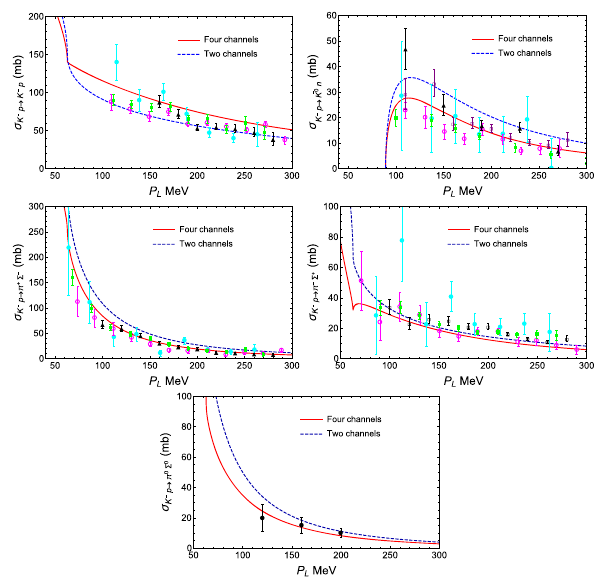
¯ K 0 n , π + (cid:4) − , π − (cid:4) + , and